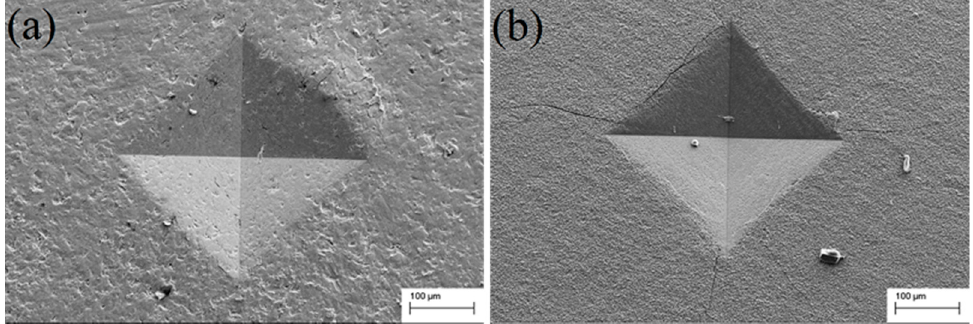
Figure 8. SEM micrographs of the Vickers indentation of both ( a ) the SMAT boriding sample and ( b ) the coarse-grained boriding sample.